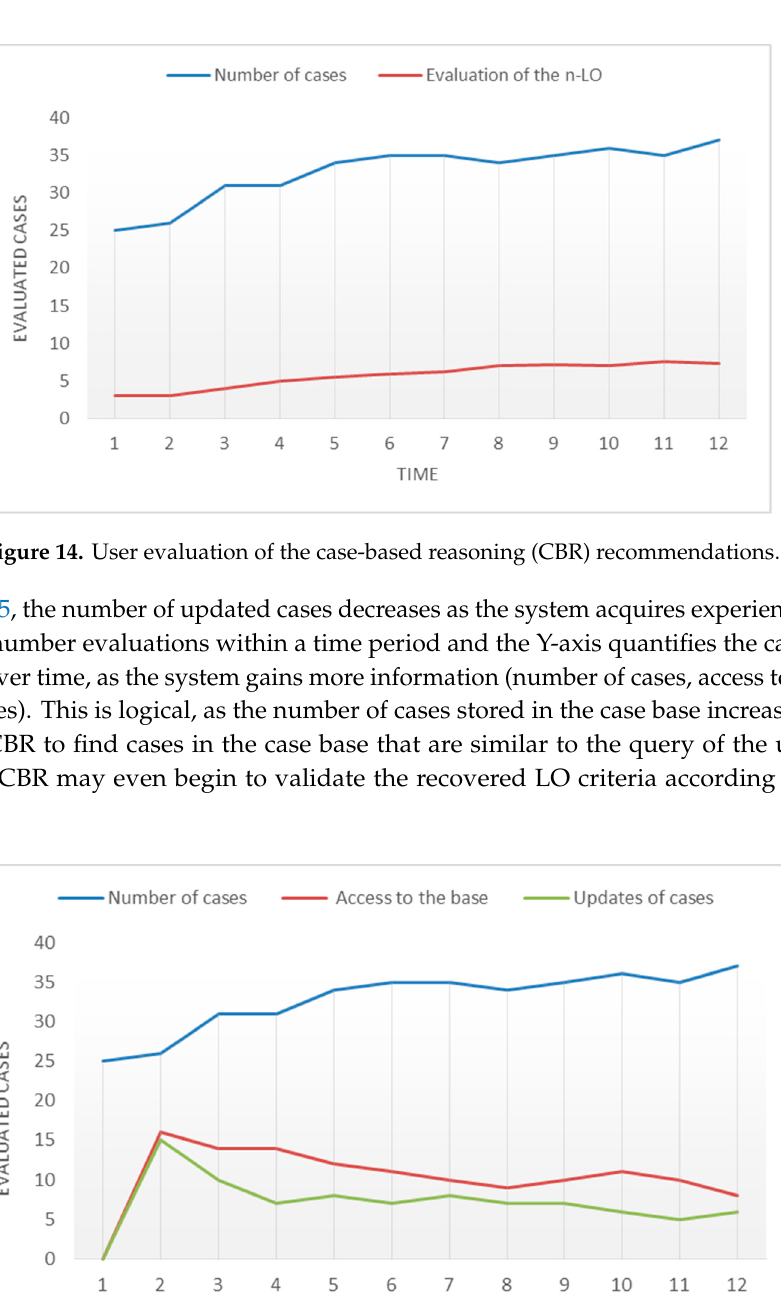
Figure 13. Sample results presentation in the User Interface (UI) AIREH tool.